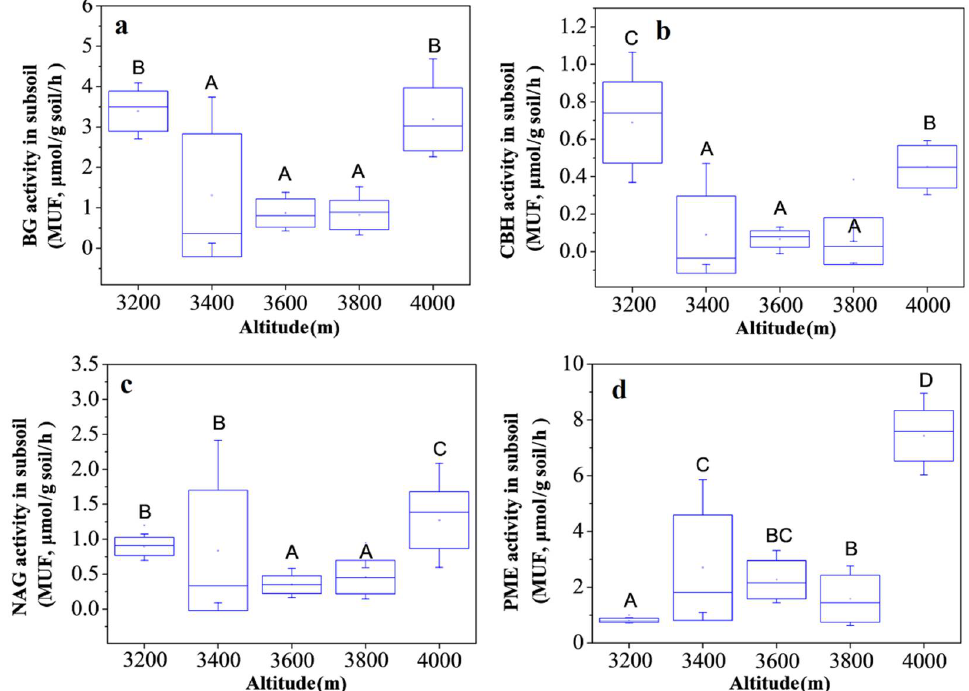
Figure 2. Soil enzyme activity in the subsoil (10–20 cm) along the altitudinal gradient of Mengbi Mountain: ( a ) BG = β - glucosidase, ( b ) CBH = cellobiohydrolase, ( c ) NAG = β -N-acetyl-glucosaminidase, and ( d ) PME = phosphomonoesterase.